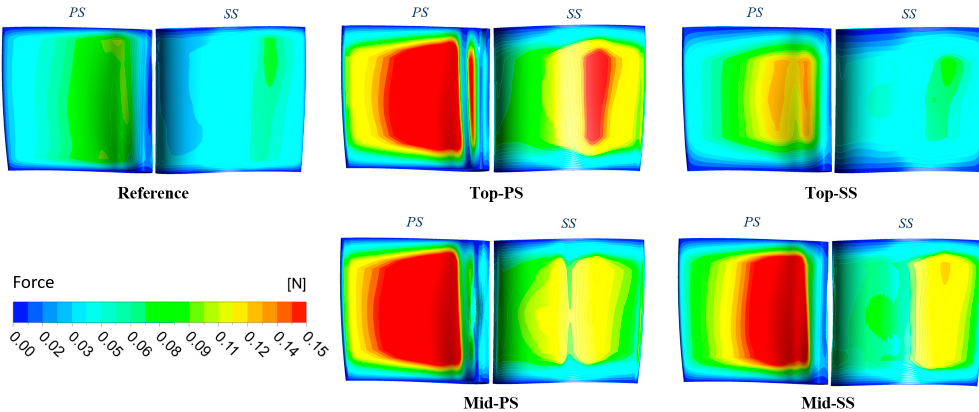
Figure 11. Surface-force distribution on the rotor blade under different damaged-blade conditions.